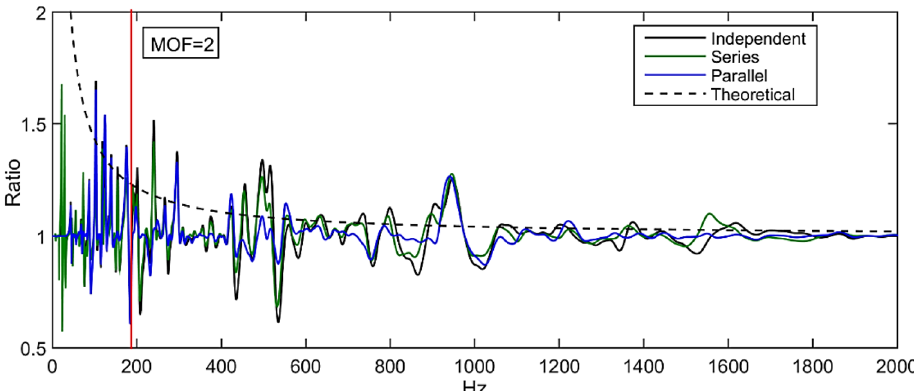
Figure 15. Controlled/uncontrolled plate energy when attached with optimal PZT shunt damper at different configurations, compared with theoretical energy ratio as derived in Eq. (21).